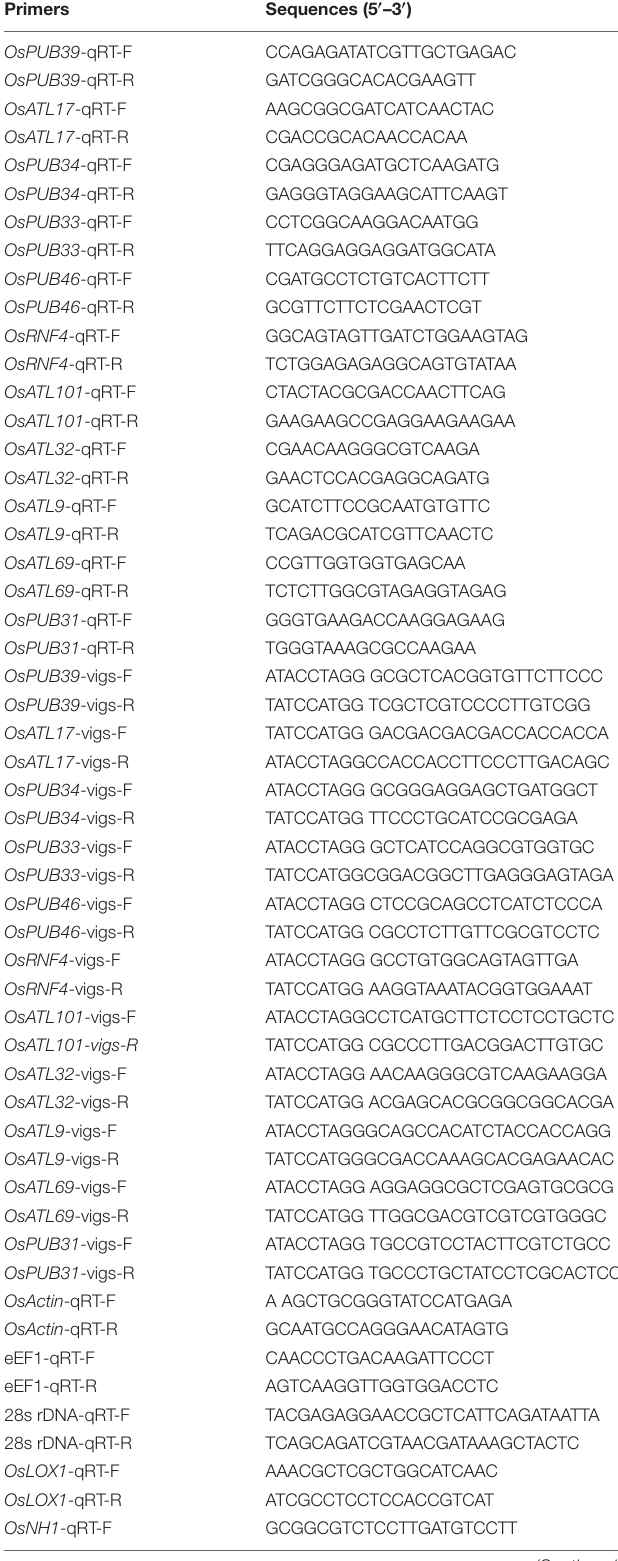
TABLE 1 | The list of primer sequences used in this study. Primers Sequences (5 (cid:48) –3 (cid:48)